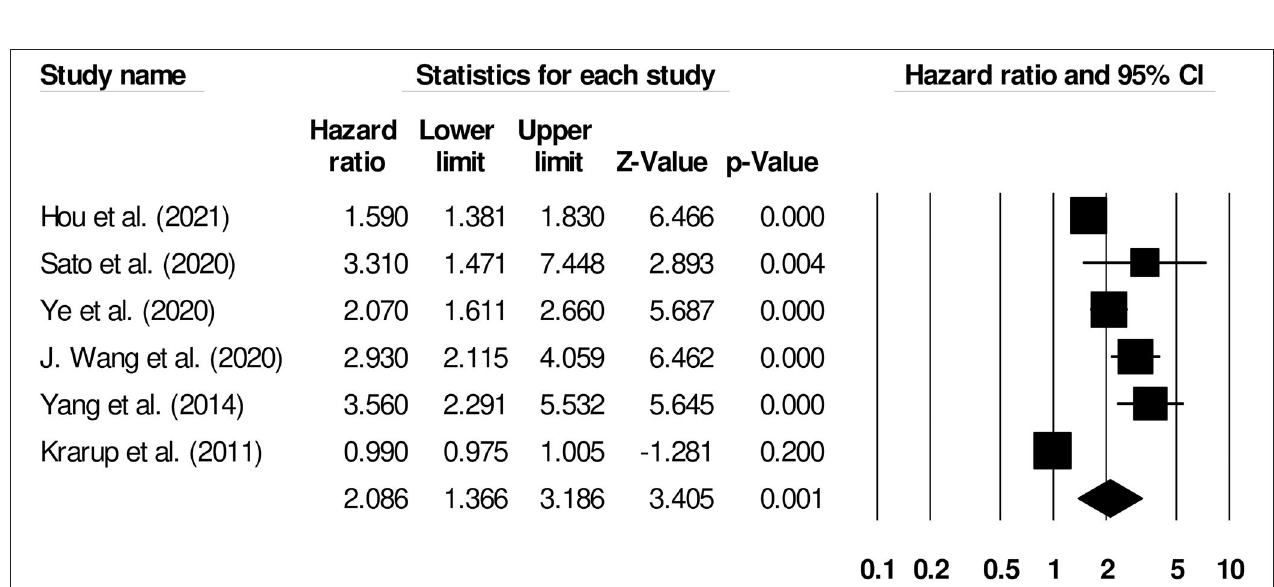
FIGURE 5 | Forest plot for studies evaluating the impact of D-dimer level on post-ischemic stroke functional outcomes. Hazard ratios are presented as black boxes while 95% confidence intervals are presented as whiskers. A small hazard ratio represents a lower influence of D-dimer levels on stroke patient functional outcome while a higher hazard ratio represents a higher